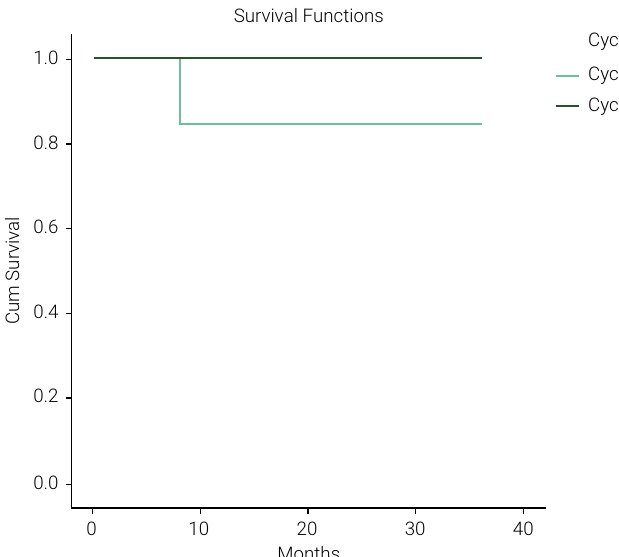
Figure 3. Cumulative local recurrence free survival curve for cyclin D1 expression in resected surgical